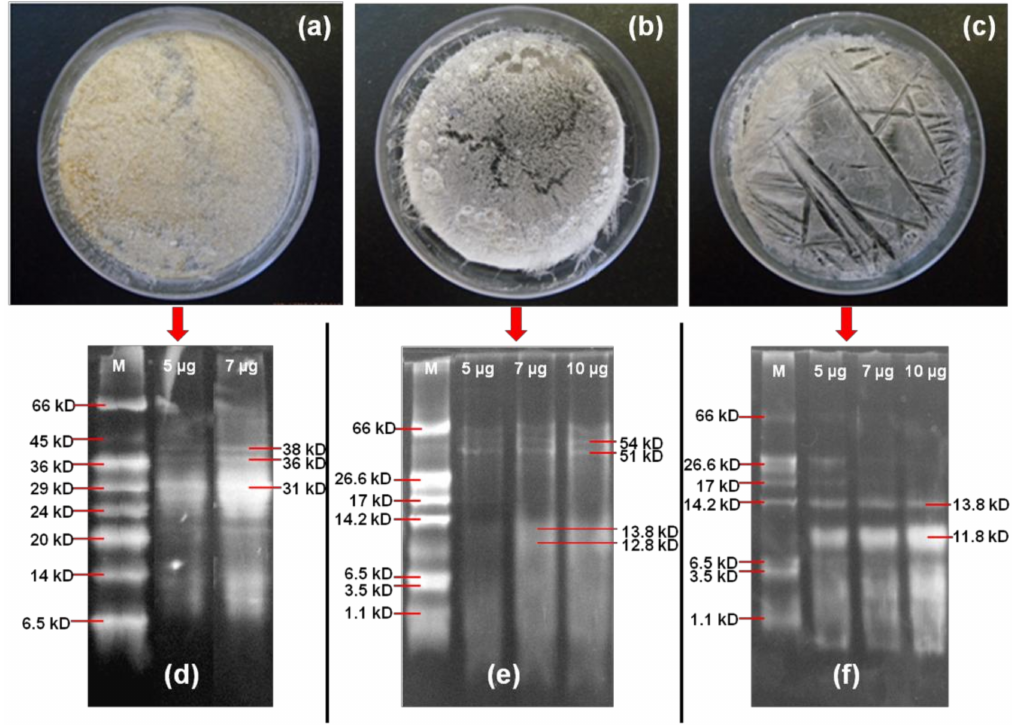
Figure 3. Physical state and molecular weight analysis of α -gliadin ( a , d ); the self-organized peptide biomaterials at 37 ◦ C ( b , e ); and the self-organized peptide biomaterials at 50 ◦ C ( c , f